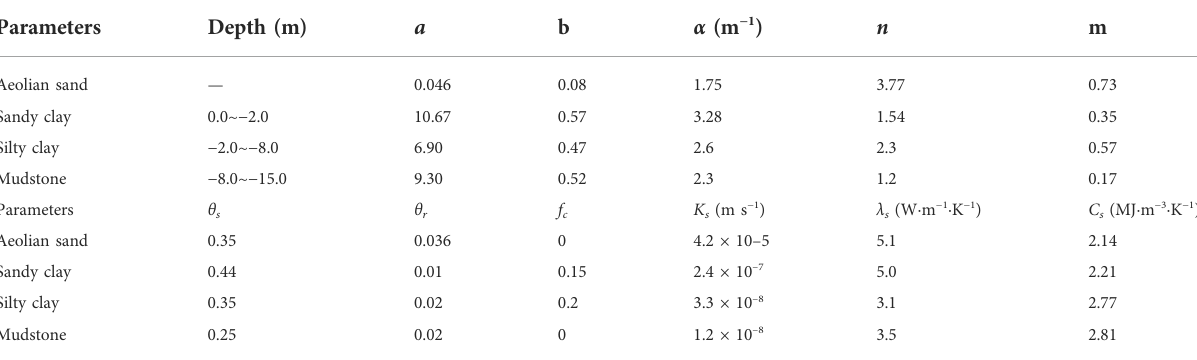
TABLE 3 Hydrothermal parameters of different soil